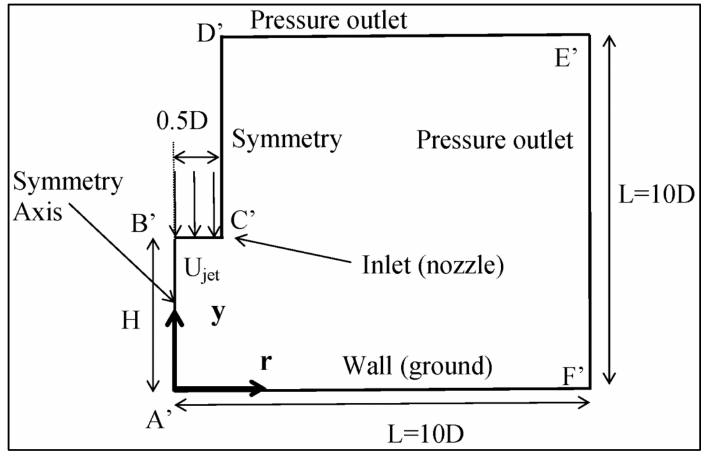
Figure 1. Two-dimensional (2D) axisymmetric computational